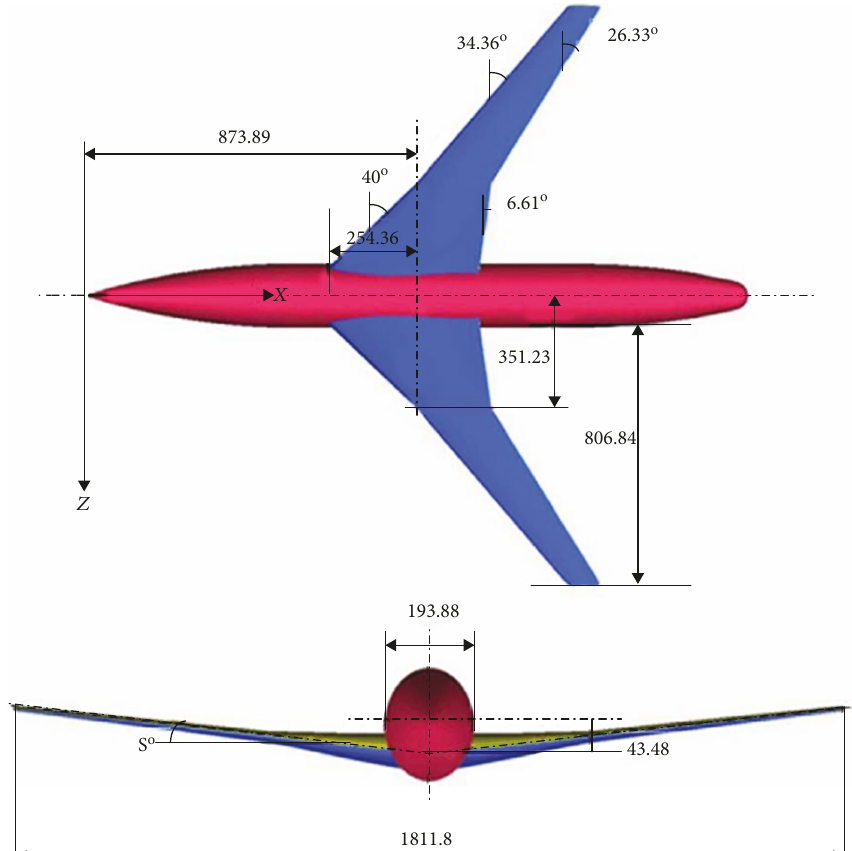
Figure 21: Basic dimension of the ARA M100 wing-fuselage model, Carr and Pallister [13].